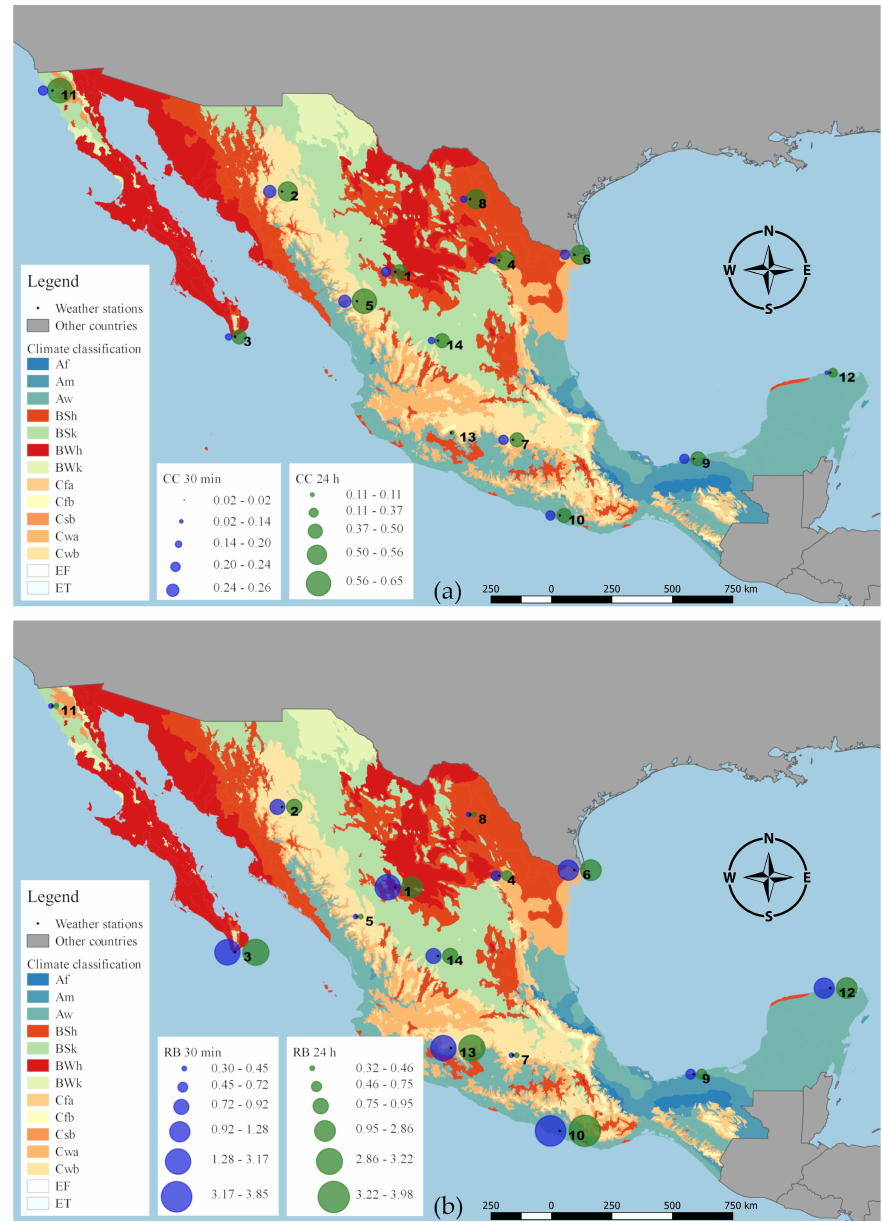
Figure 9. Spatial distribution of ( a ) CC and ( b ) RB obtained from the analysis between the precipitation data observed by the weather stations and the CMORPH estimates, for the two levels of temporal aggregation